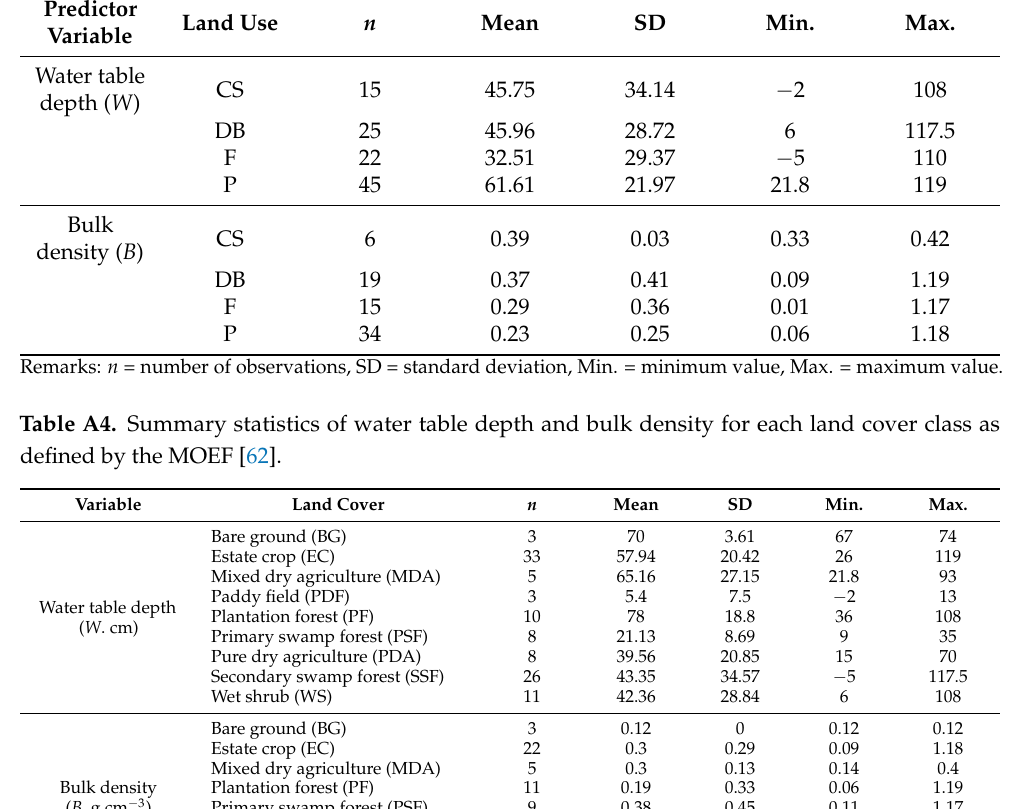
Table A3. Summary statistics of water table depth and bulk density for each land cover class as defined by Prananto et al. [61]. Predictor Land Use n Mean SD Min. Max. Variable Water table CS depth ( W )